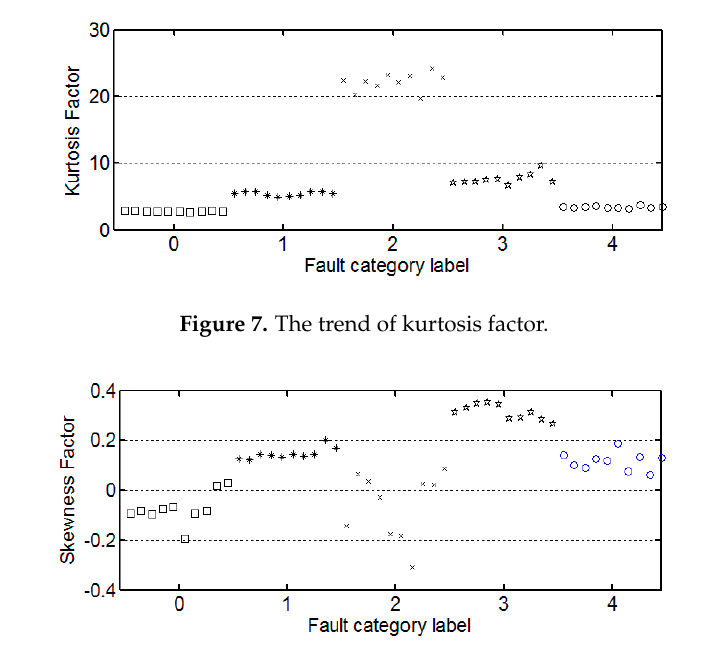
Figure 6. The trend of margin factor.